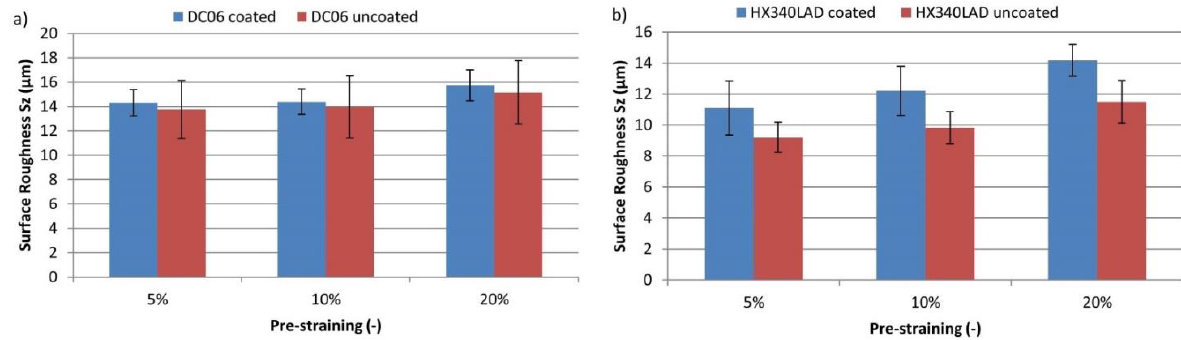
Figure 7. ( a ) Strain-induced surface roughening of coated and uncoated DC06 sheet; ( b ) strain-induced surface roughening of coated and uncoated HX340LAD sheet.